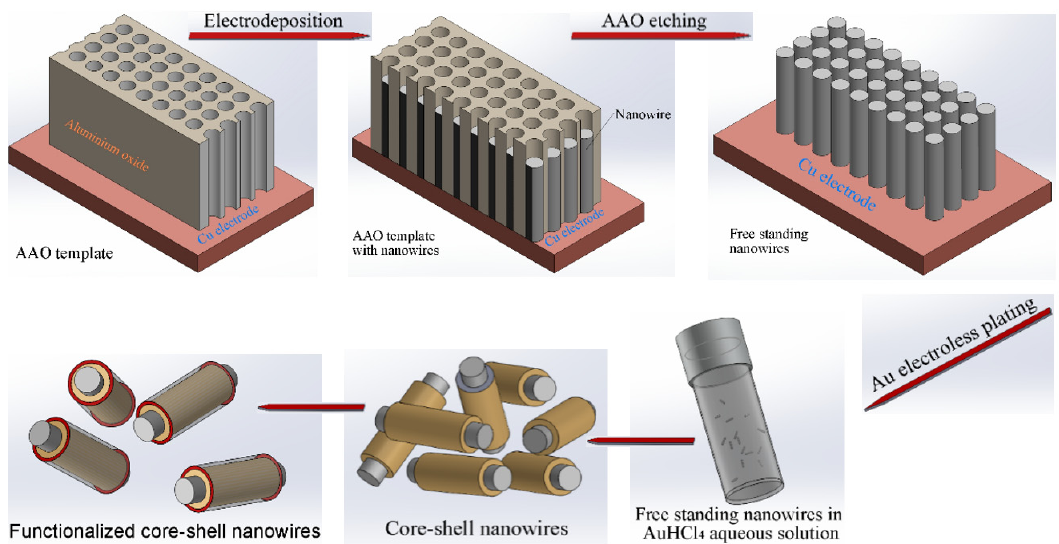
Figure 1. Schematic diagram of preparation of core–shell nanowires. The nanowires were functionalized with Thiol-PEG-Carboxyl (SH-PEG-COOH).